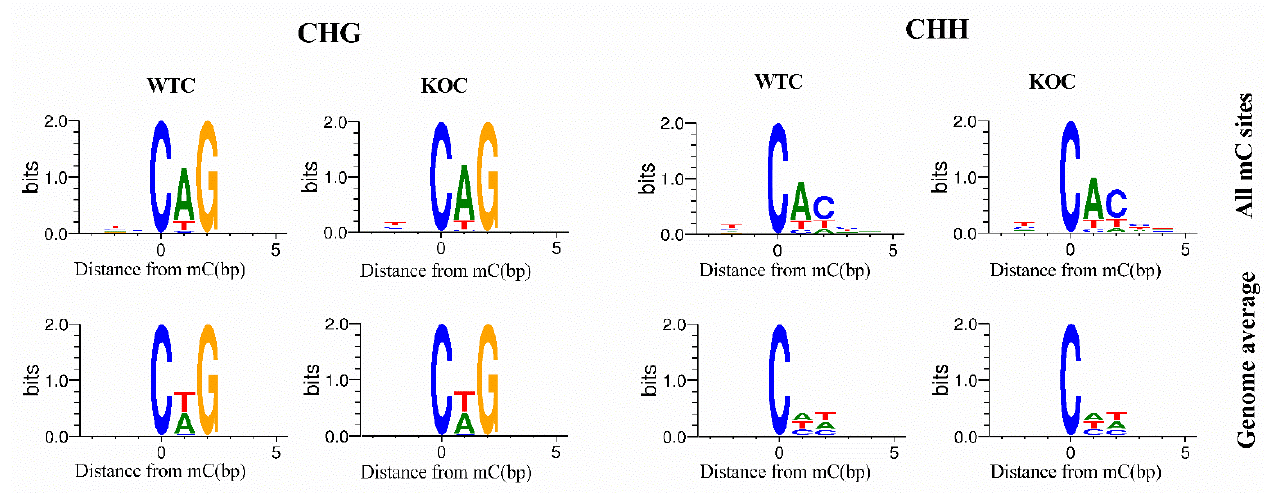
Figure 3. Logo plots of the sequences proximal to sites of non-CG DNA methylation in each sequence context. The abscissa axis indicates base positions and the ordinate axis indicates the degree of base enrichment. Four different colors represent the different bases (color version of this figure is available at Bioinformatics online).